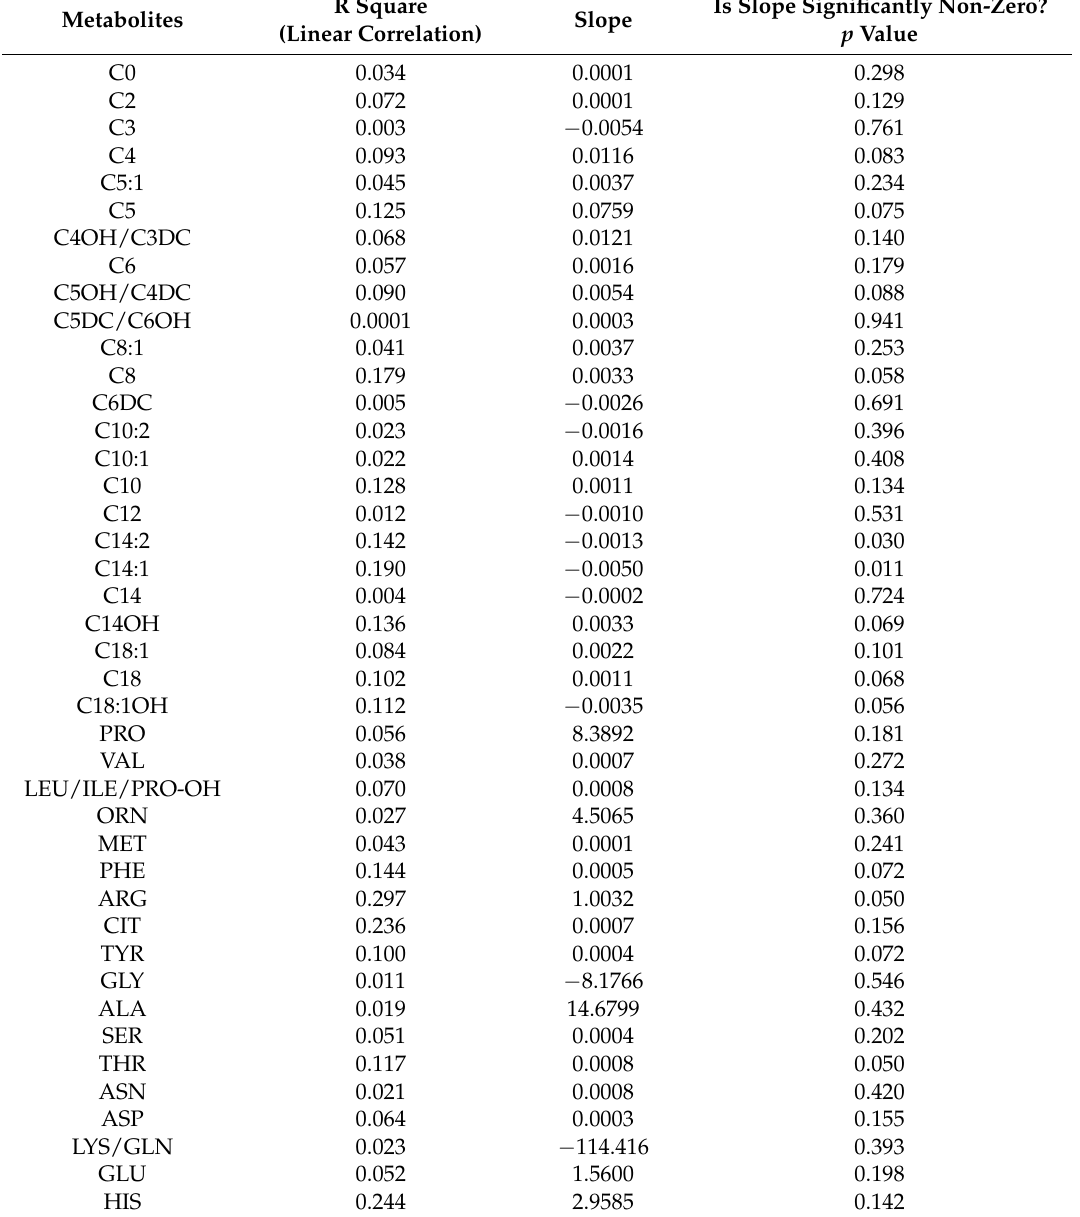
Table 1. Linear regressions performed between the levels of forty-two metabolites in thirty three Schirmer’s strip imbibed with different millimetres of tears (from 1 mm to 35